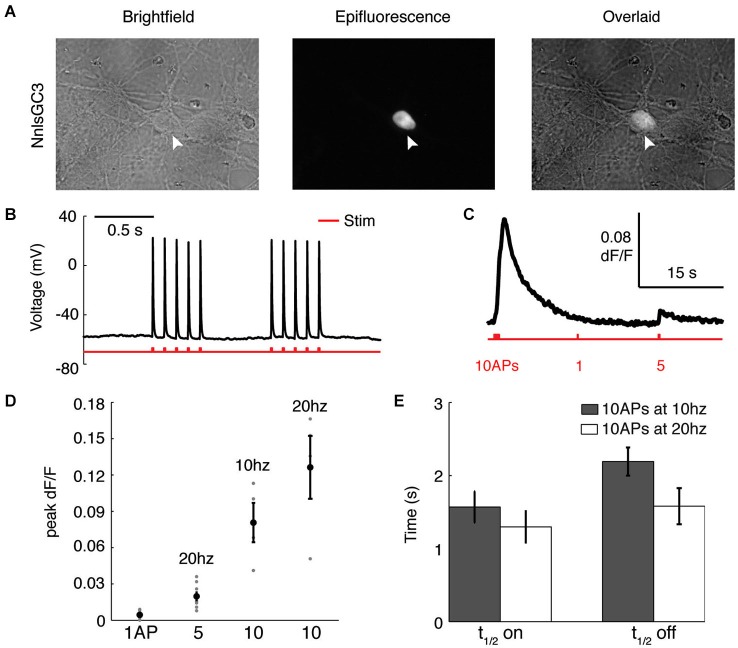
NnlsGC3 reliably reports action potentials in cultured neurons. (A) Brightfield and epifluorescence images of dissociated rat hippocampal neurons transfected with NnlsGC3. White arrowheads point to a cell in which clear nuclear inclusion of GCaMP3 is observed. (B) Example intracellular whole-cell recording of a cultured neuron in response to 10 ms, 500 pA electrical field stimulation pulses. (C) Fluorescence time series of a cell’s response to 10 APs at 10 Hz, 1 AP, and then 5 APs at 20 Hz (500 pA 5 ms pulse). (D) Mean peak change in fluorescence in response to 1 AP, 5 APs at 20 Hz, 10 APs at 10 Hz, and 10 APs at 20 Hz. Error bars represent ± SEM. (E) Mean t1/2on and t1/2off in response to 10 APs at 10 and 20 Hz.